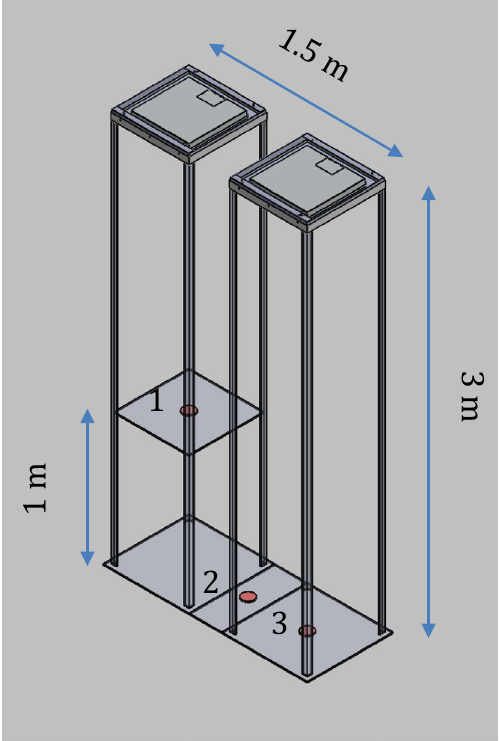
Figure 3. Schematic representation of the experimental setting. The VBL405 LED light sources are located on the top of the structure. Petri dishes are centered in three positions (red circles): (1) 2 m under one lamp; (2) 3 m under the light sources, midway between them; (3) 3 m under the other